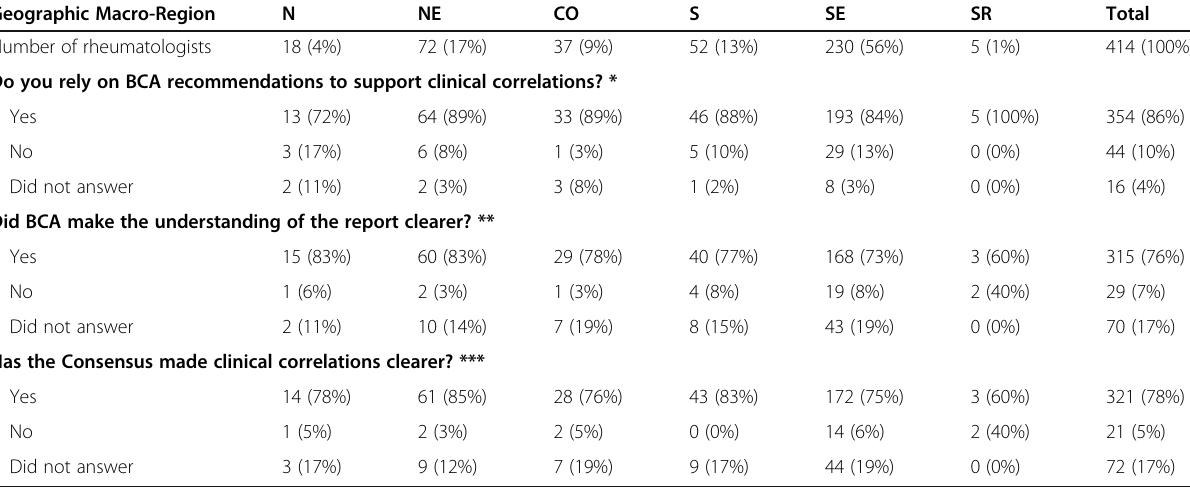
Table 4 Rheumatologist ’ s perception of the role of the Brazilian Consensus in clinical practice Geographic Macro-Region N NE CO S SE